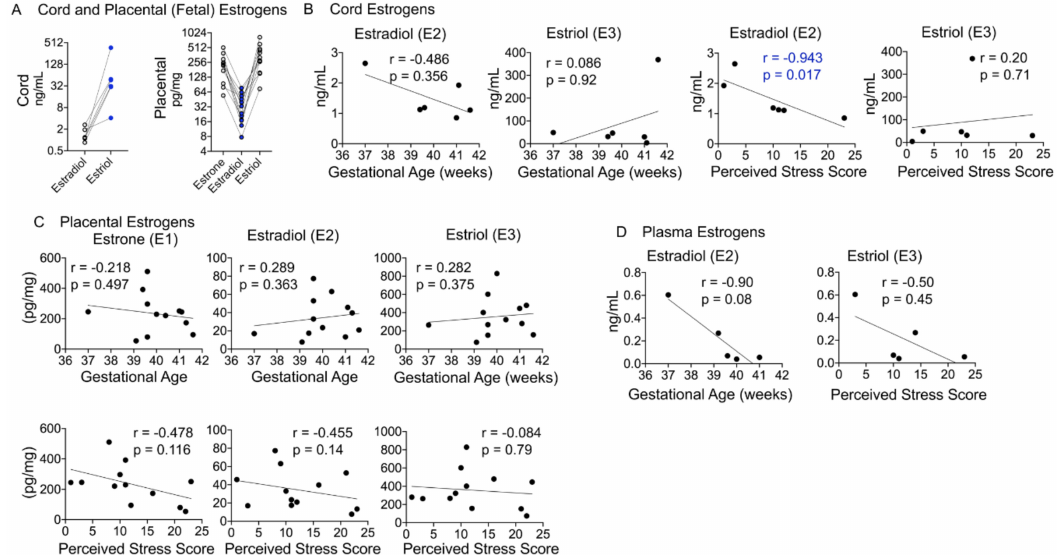
Figure 7. Maternal–fetal estrogen metabolites and correlation with birth outcomes and the PSS. ( A ) Cord estriol levels were ~20-fold higher than estradiol levels and increased in each individual. In the placenta, estrone and estriol levels were higher than estradiol levels, which were lowest in each participant. ( B ) While neither cord E2 nor E3 levels correlated with gestational age, E2 levels were significantly negatively correlated with the PSS ( r = − 0.94, p = 0.017). ( C ) Placental estrogens did not correlate with gestational age or the PSS. ( D ) Plasma E2 levels showed a strong negative correlation with gestational age, with a trend toward significance ( r = − 0.90, p = 0.08). Mann–Whitney U test and Spearman’s correlation